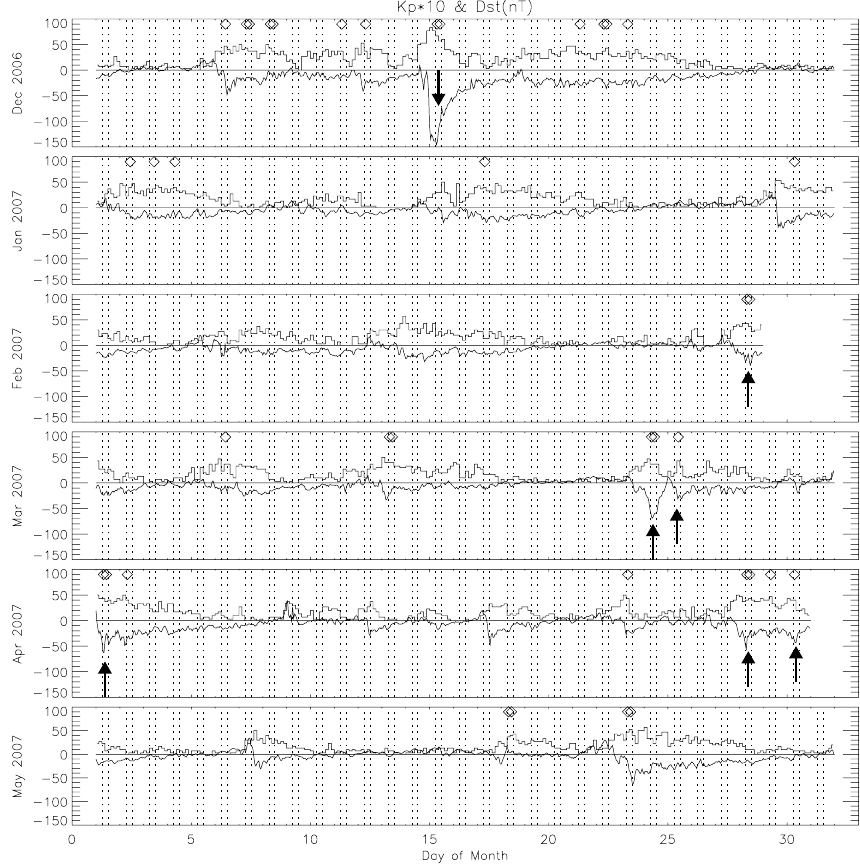
Fig. 3. The D st and K p *10 indices during the first 6 month period of Hokkaido radar observation. Vertical dotted lines show the time interval from 06:00 to 12:00UT when the Hokkaido radar observed 20:00MLT as shown in Fig. 1. Diamonds show the disturbed time period of K p > 3+, while arrows show the appearance of enhanced westward